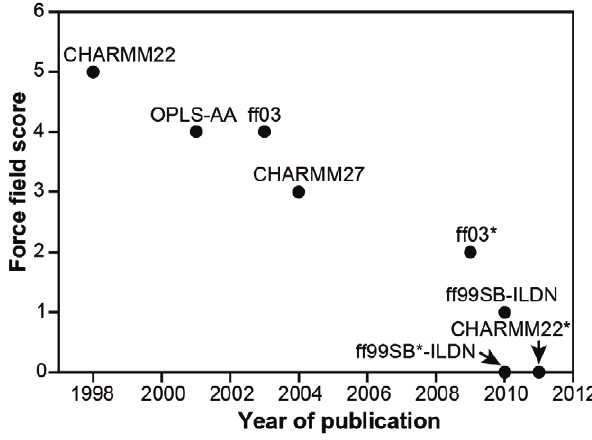
Figure 3. Improvement of force fields over time. For each force field, we assigned a score depending on the agreement with experiments in the tests presented here. Low scores indicate good agreement with experiments. These scores are plotted against the year in which the force field was published. For the force fields that involve multiple corrections (e.g., ff99SB*-ILDN), we use the year of the most recently published correction.